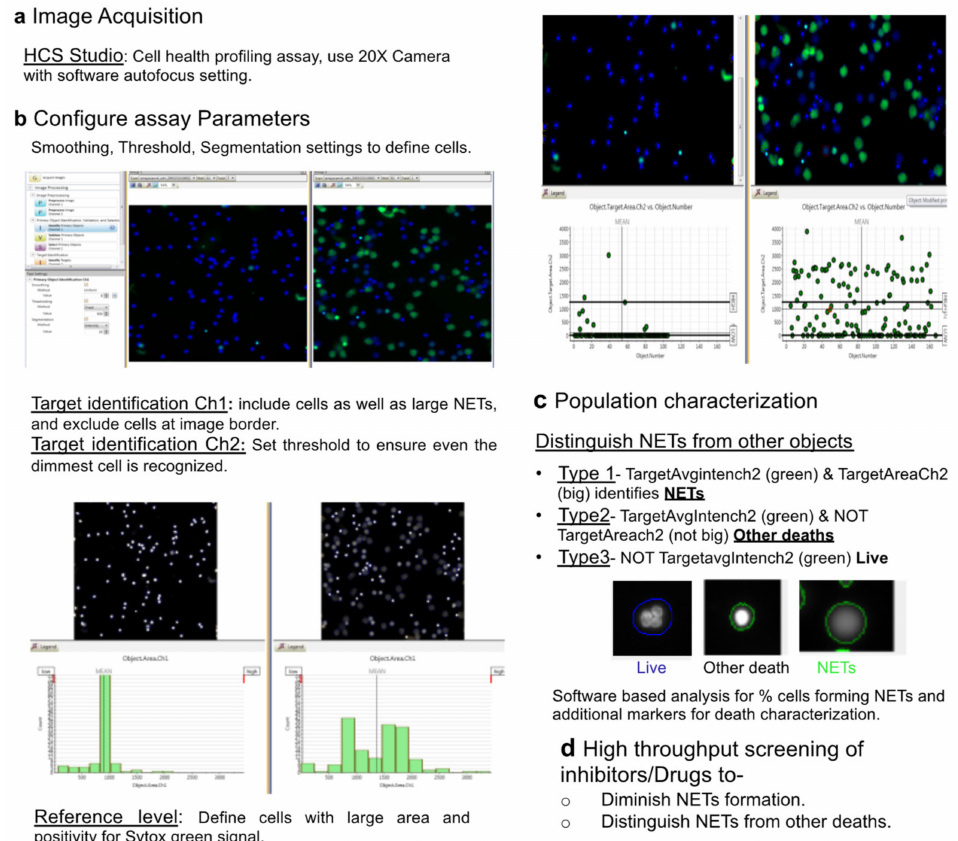
Figure 1. Representation of HCS Cellomics approach-based acquisition and specific detection of NETs. ( a ) HCS studio and cell health bioapplication-dependent image acquisition using 20 × objective after Hoechst 33342-based autofocus of cells. ( b ) Configure assay parameters for visualization of NETs at single cell level. Identify primary objects using smoothing, threshold, and segmentation in channel 1 and channel 2. Revalidate the primary objects data after visualization of cells in the green and blue channel with the change in cell area and signal intensities and threshold. Select reference levels to differentiate between live, NET forming, and cells with compromised membrane integrity and no nuclear decondensation. ( c ) Identify distinct populations using differential Sytox average intensity Ch2 and Target Area Ch2 for different sets of parameters. Confirmed the results using back analysis of cell under investigation with particular area and intensity. ( d ) Apply this approach for high throughput screening of inhibitors/drugs as mitigator of NETs formation and/or switching to other